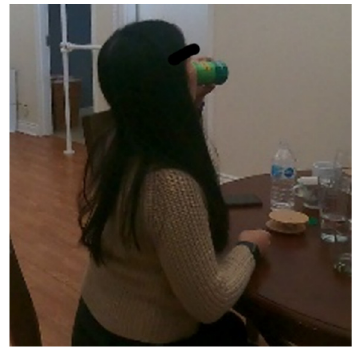
Figure 9. Subject 2 sitting in a position where their face is slightly occluded from the camera.